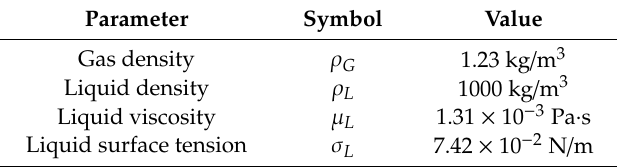
Table 1. Physical properties of the gas phase (air at 15 ◦ C) and the liquid phase (water at 10 ◦